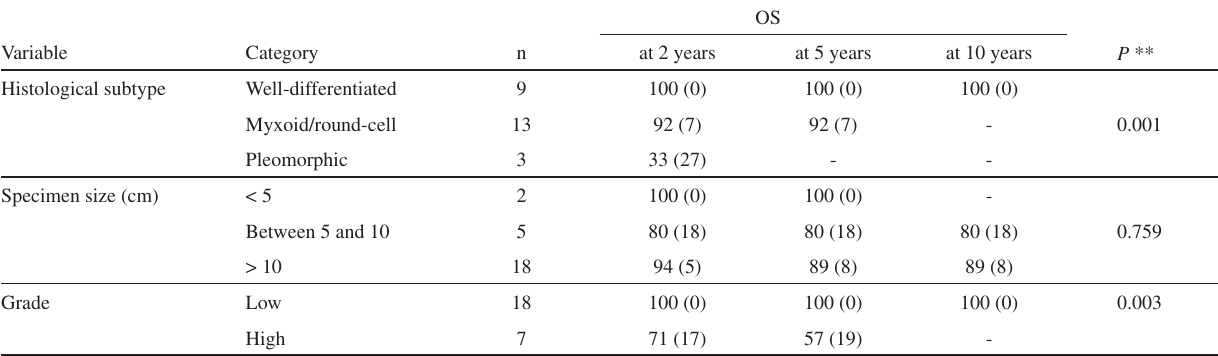
Table 2 - Anatomical and pathological variables—overall survival (OS) at 2.5 and 10 years for the 25 patients with primary liposarcomas of the